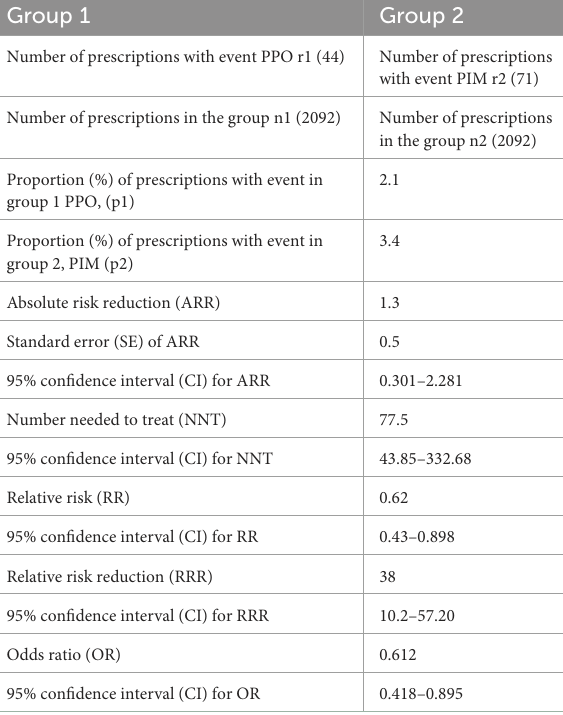
TABLE 7 Risks for PIMs, and PPOs at patient level. Group